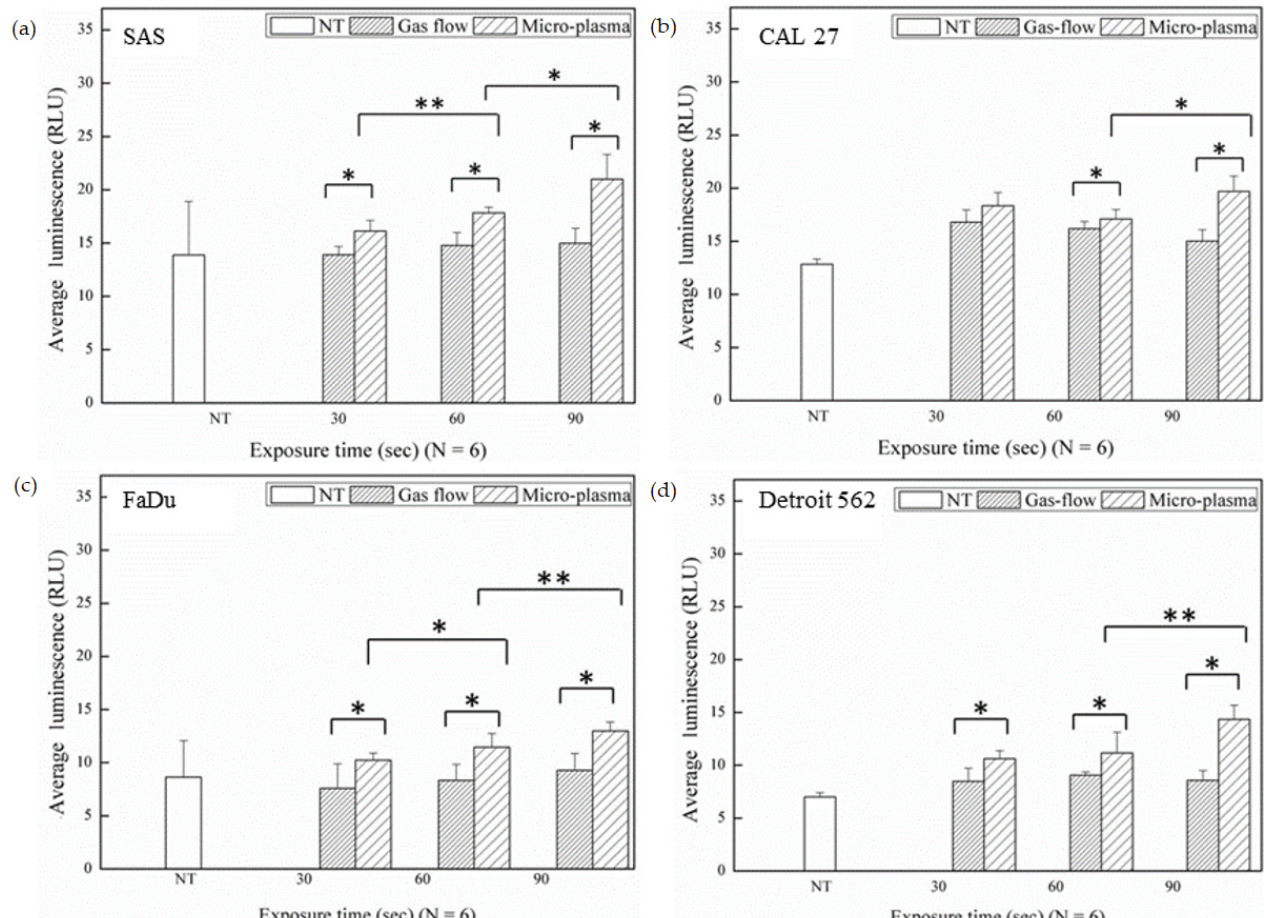
Figure 1. ROS content in the stimulated medium with ( a ) SAS, ( b ) CAL 27, ( c ) FaDu, or ( d ) Detroit 562 after plasma exposure and gas flow for a similar duration and then cultured for 48 h. The medium without cells and the medium with cells and gas flow for a similar duration were taken as the references. The values of p < 0.05 (*) and p < 0.01 (**) were considered statistically significant.